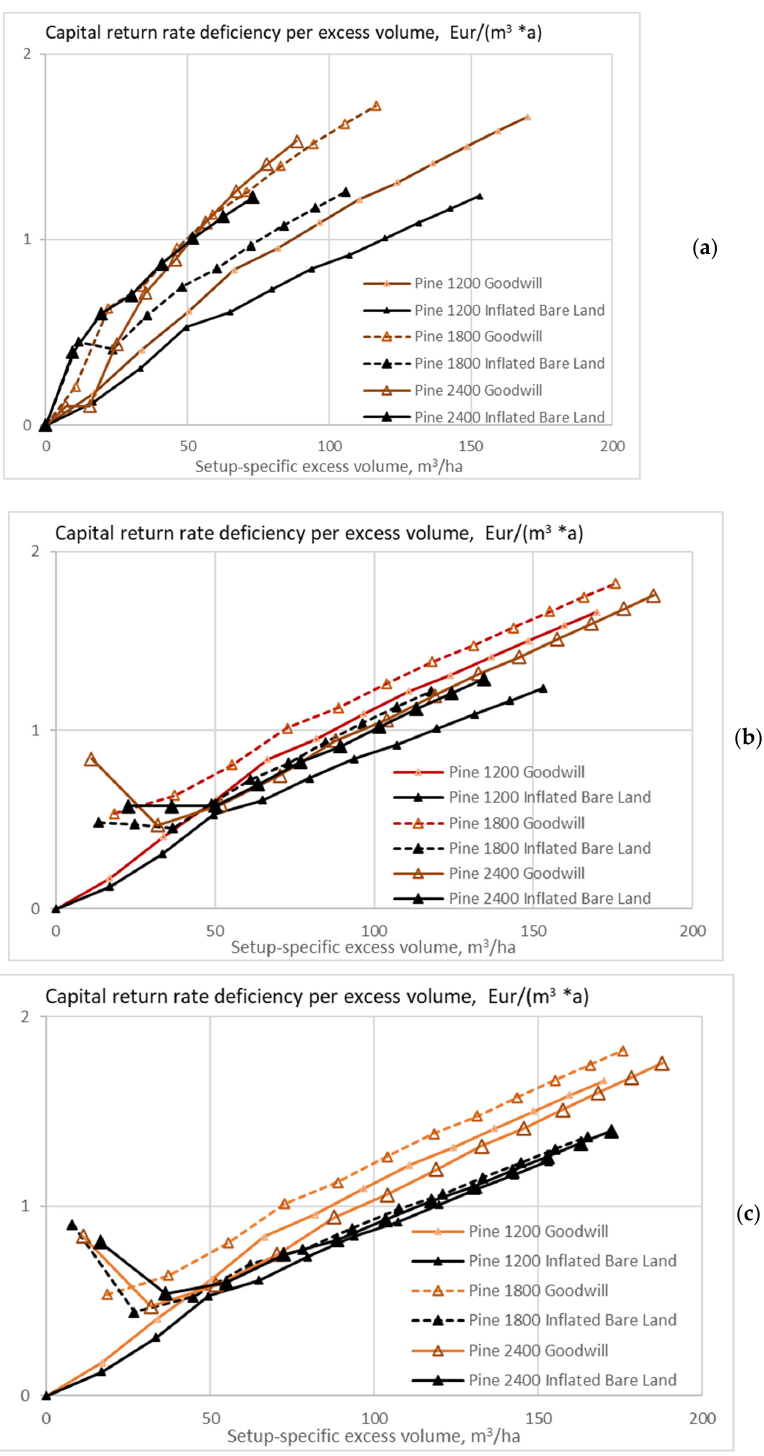
Figure 13. The expected value of capital return rate deficiency per excess volume unit on pine stands of different initial sapling densities, as a function of excess volume, when the growth model is applied as early as applicable, without any thinning restriction ( a ) and in good-quality trees of at least 238 mm of diameter only removed in thinning ( b ), and without any commercial thinning ( c ). Inflated capitalization is introduced either as proportional goodwill or as inflated bare land value.